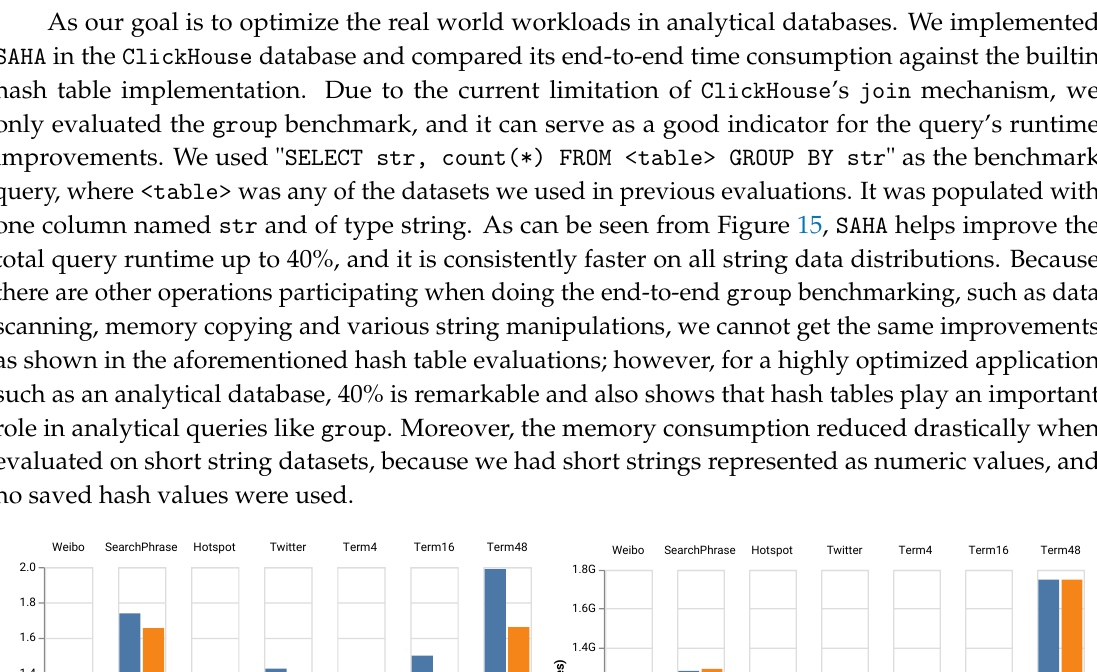
Figure 14. A bar graph of the time consumption of various hash functions for group benchmarks on two datasets with short and long string length distributions (Weibo and SearchPhrase).